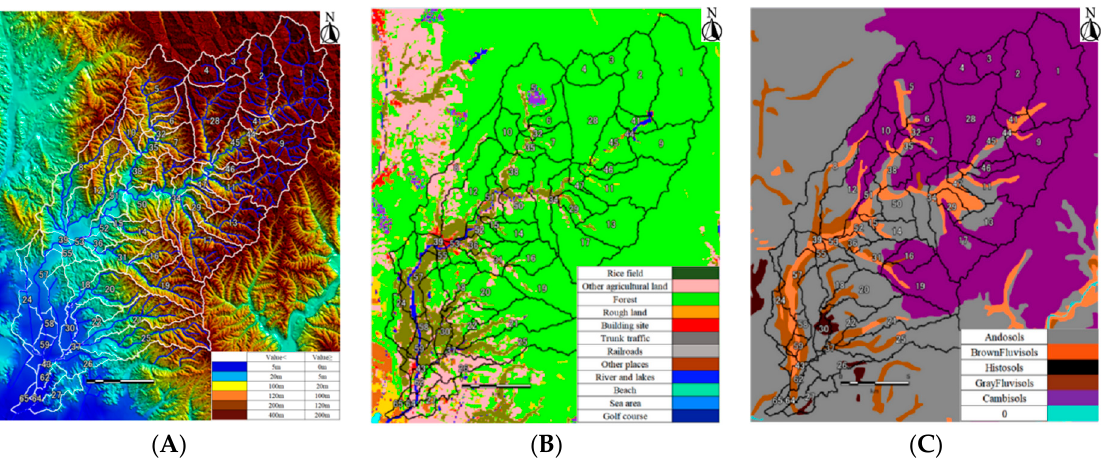
Figure 5. The elevation ( A ), land use ( B ), and soil ( C ) conditions in Atsuma River basin. Daily precipitation at 450 radar precipitation stations in the Atsuma River basin were used to run the model. The minimum and maximum temperature data, average wind speed data at Atsuma station were used, the relative humidity data at Tomakomai station was used, the solar radiation data at Sapporo station was used.